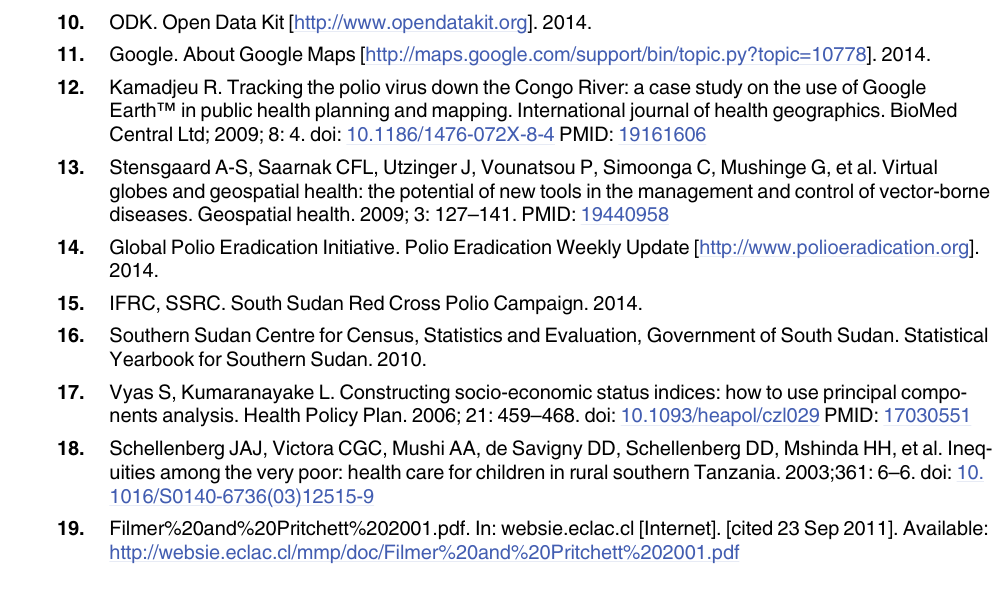
PLOS ONE | DOI:10.1371/journal.pone.0135362 August 7,